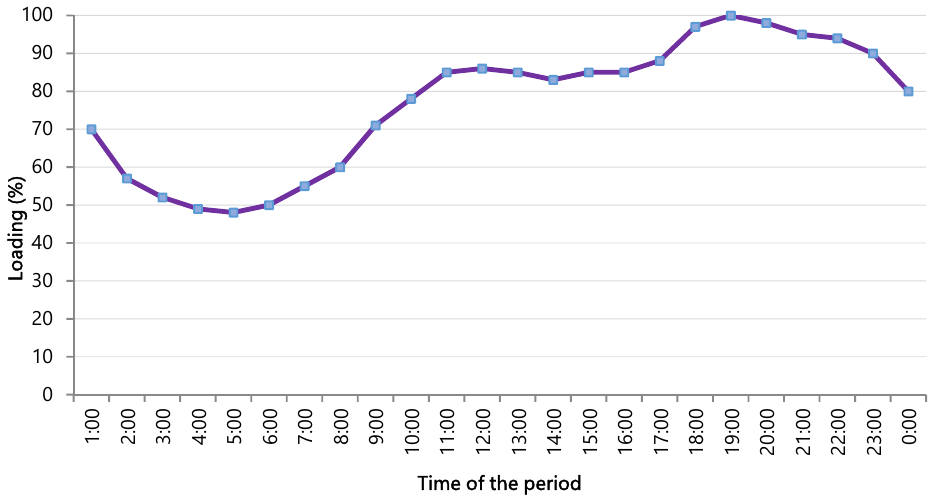
Figure 2. The used radiation data taken from National Renewable Energy Laboratory (NREL).